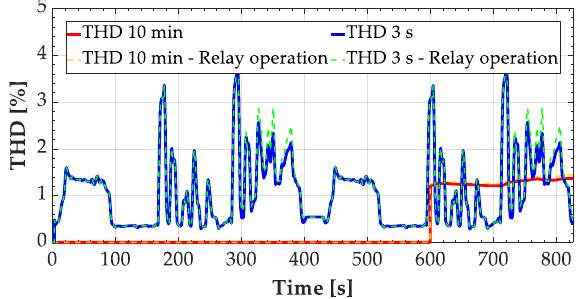
Figure 20. Results from the thermal analysis. ( a ) Without including the effect of solar irradiance; ( b ) including the effect of solar irradiance; ( i ) initial state; ( ii ) state at 293.5 s